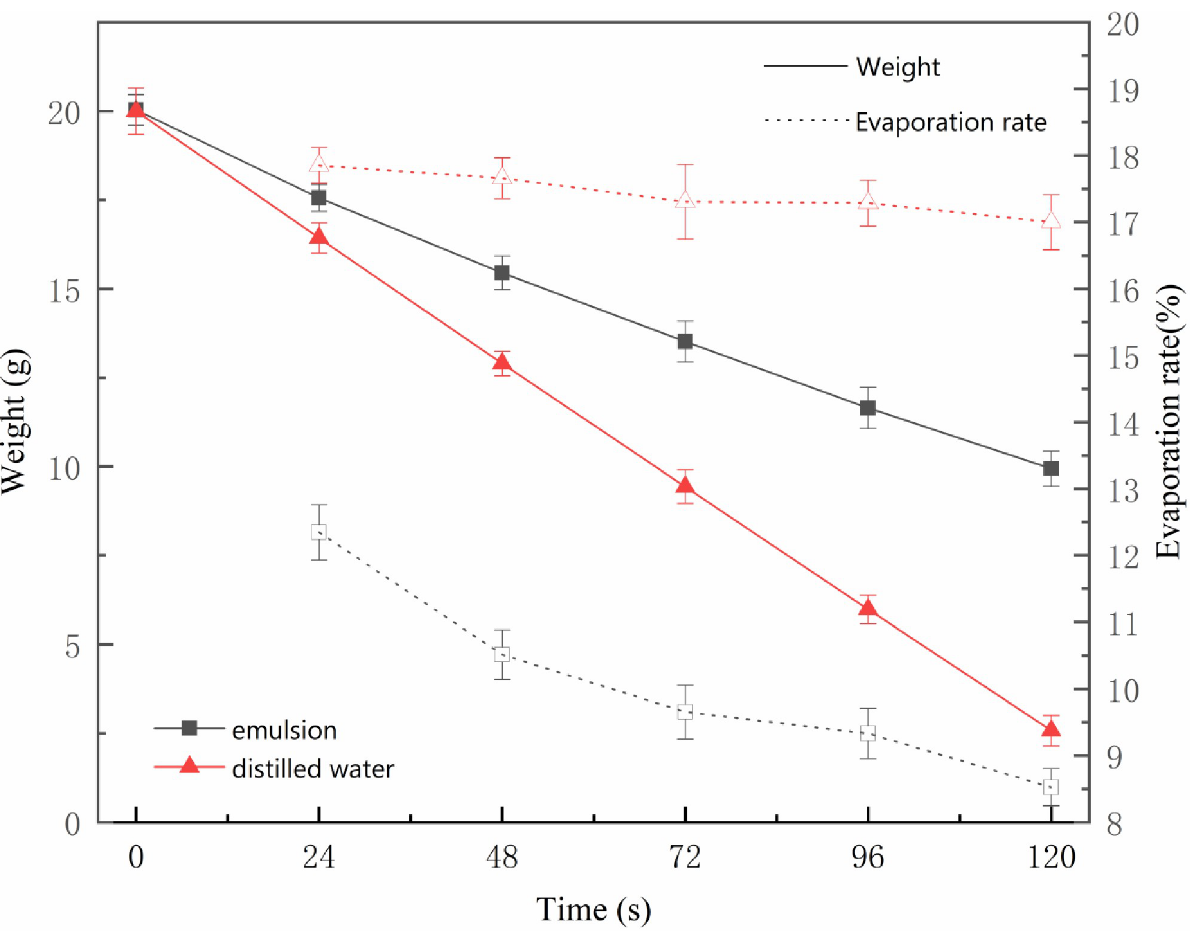
Fig 4. Changes in evaporation of distilled water and